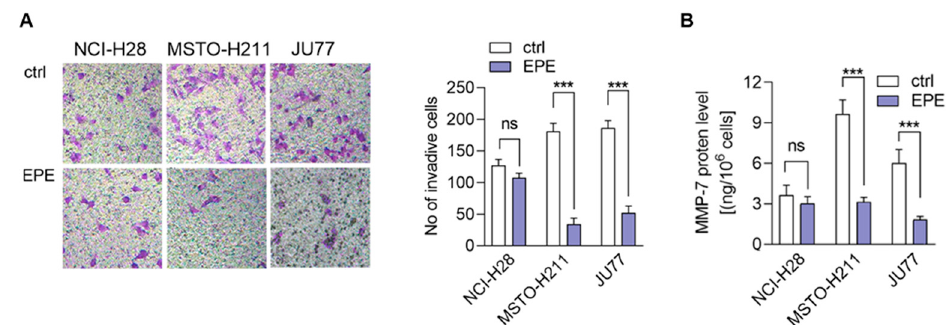
Figure 6. EPE inhibited the invasive ability of MSTO-H211 and JU77 cells. ( A ) The MPM pre-treated cells were put on the Boyden chamber with Matrigel ® placed on a 24-well plate. The cells migrated to the medium with 20% FBS that filled the lower part of wells for 8 hrs. Then it was fixed, labelled with 1% crystal violet, and captured. The analysis was made in ImageJ software. ( B ) The level of MMP-7 was determined in conditioned medium obtained from EPE-treated MPM cells. Data are the means of three independent experiments ± SD, ns: non-statistical, *** p < 0.005 compared to control.